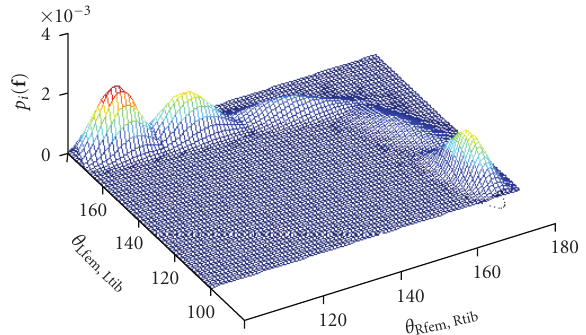
Figure 3: θ Rfem,Rtib versus θ Lfem,Ltib with 5